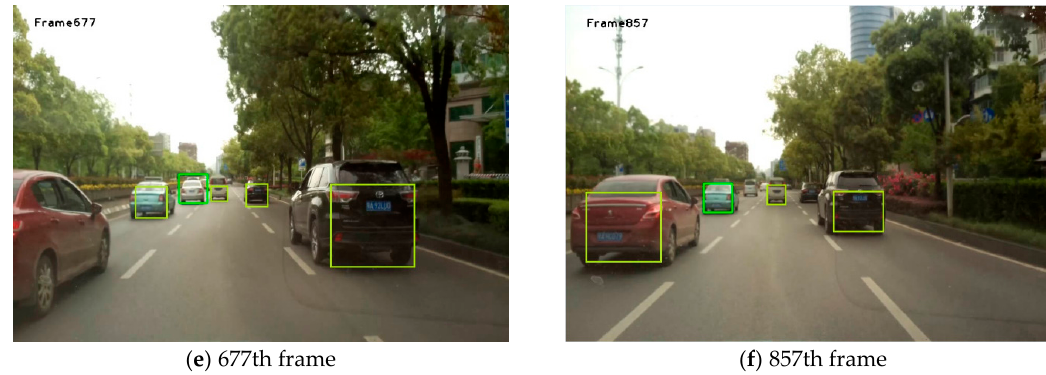
Figure 10. Part of the front-vehicle detection results in Video 3.